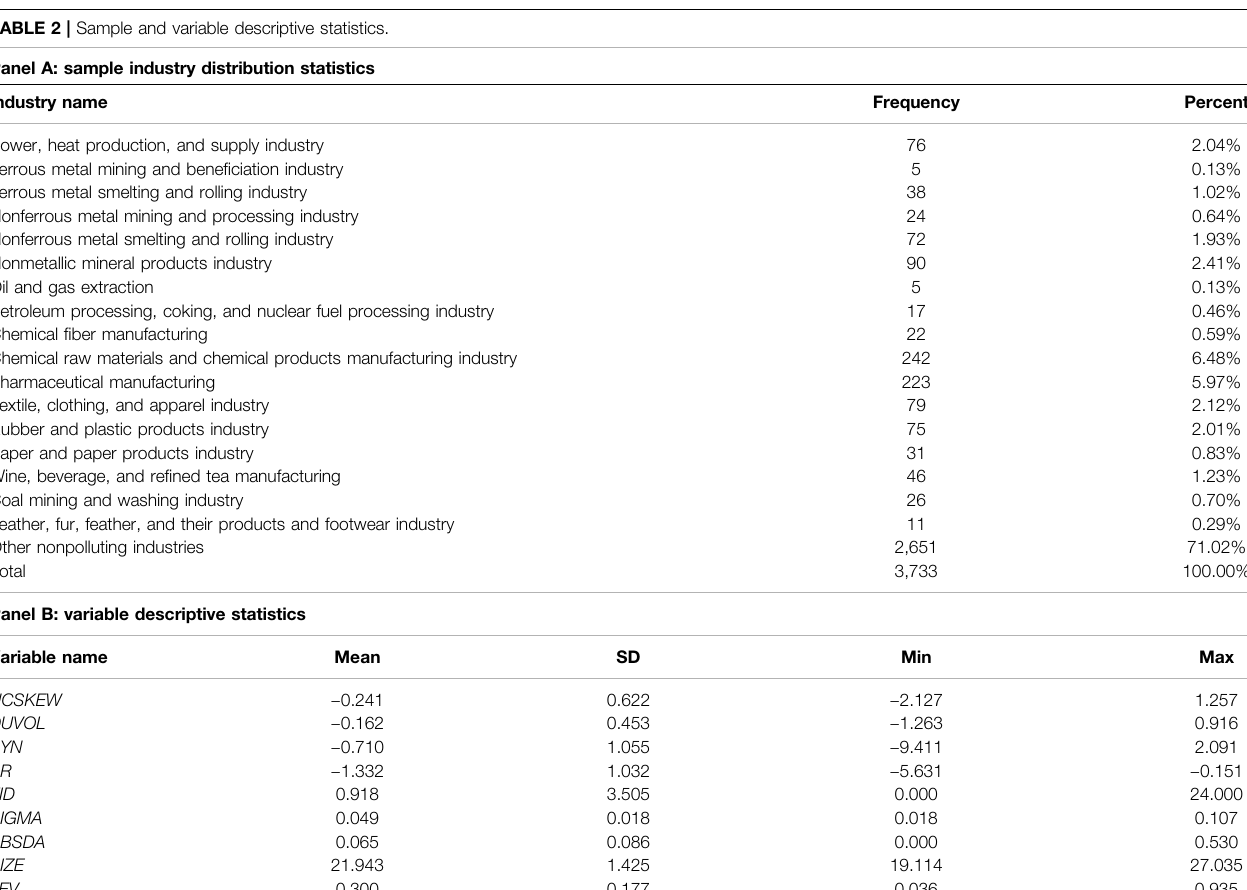
TABLE 2 | Sample and variable descriptive